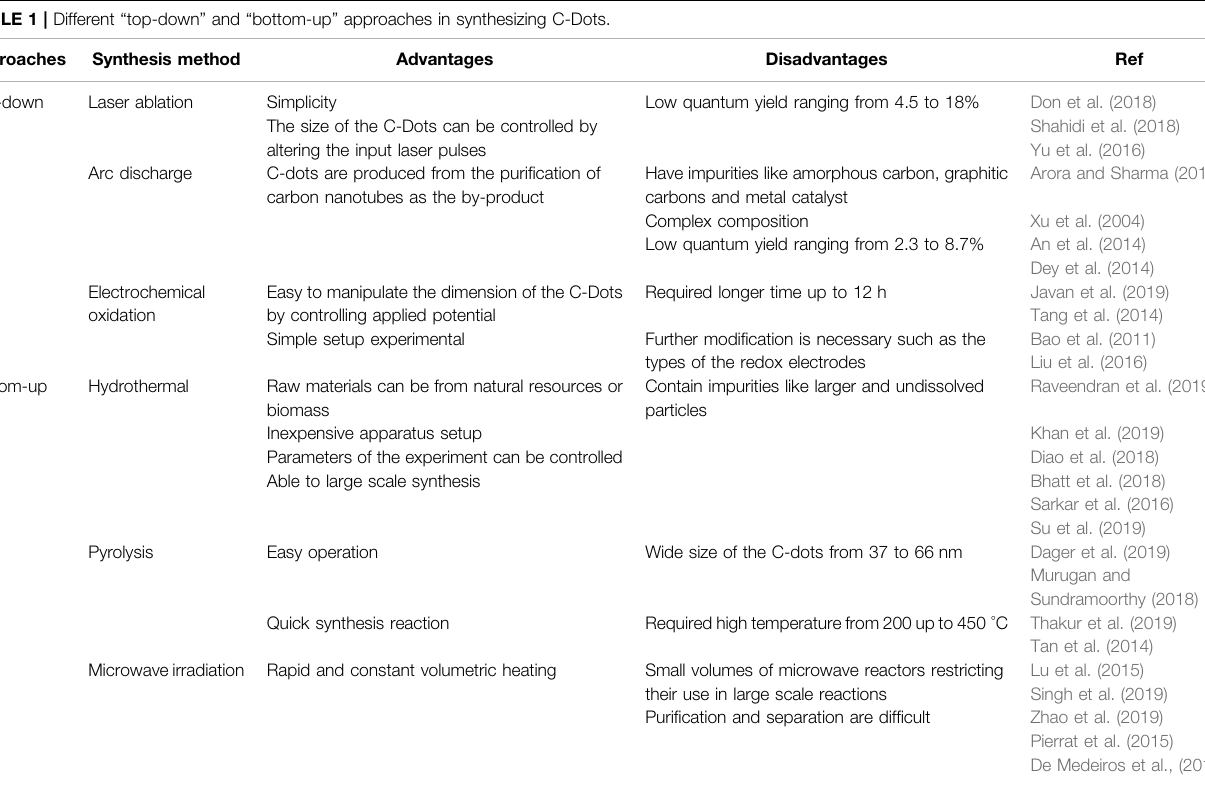
Frontiers in Energy Research |